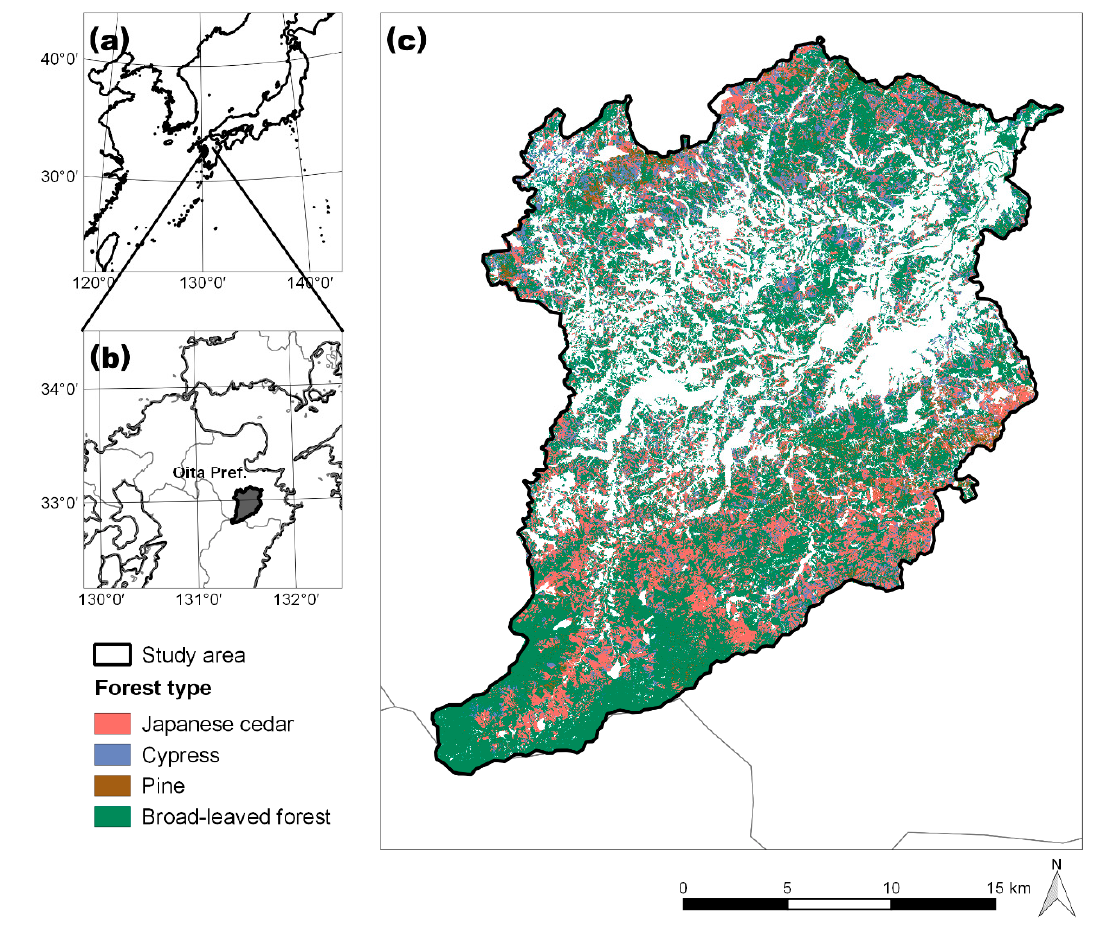
Figure 1. ( a , b ) Location map and ( c ) forest type distribution map of the study area. Forest type distribution was visually interpreted from the aerial photographs acquired in 2014.